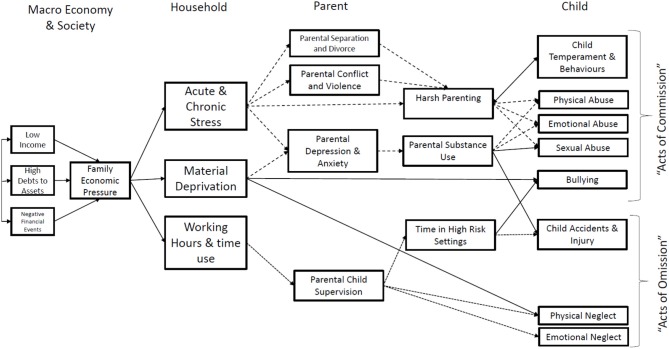
Distal and proximal influences on adverse childhood experiences.